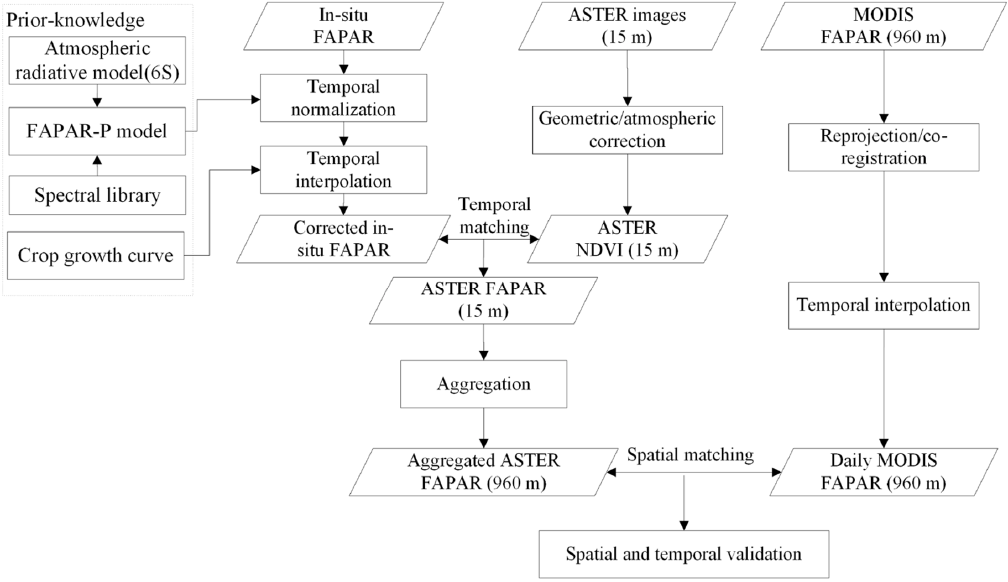
Figure 2. Methodology of scaling Fraction of Absorbed Photosynthetically Active Radiation (FAPAR) from the field to the satellite.